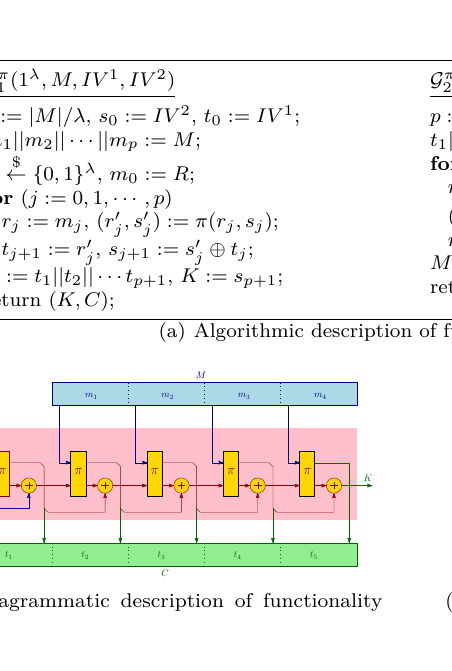
Figure 17: Algorithmic and diagrammatic descriptions of the functionalities G π and G π 1 2 are shown in (a), (b) and (c); here, π is a 2 λ -bit easy-to-invert permutation. Each wire in (b) and (c) represents λ bits. The function G π takes as inputs parameter 1 λ , message M 1 and two other values IV 1 and IV 2 , and returns the decryption key K and the ciphertext C . Similarly, G π takes as inputs parameter 1 λ , decryption key K , the ciphertext C and 2 value IV 1 , and outputs the message M and value IV 2 . For the sake of simplicity, we assume that | M | is a multiple of security parameter λ